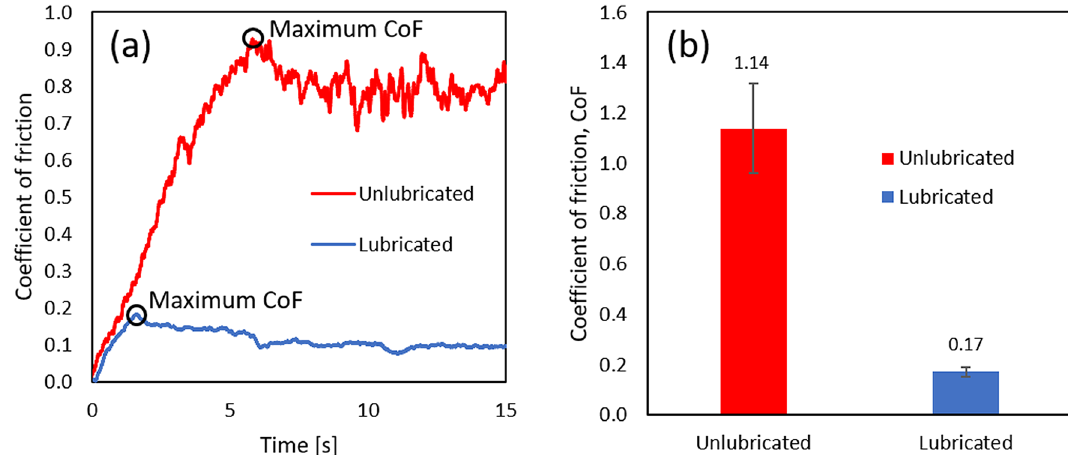
Figure 2. ( a ) Typical friction curves obtained from an individual in-vivo sliding test and ( b ) the average maximum static CoF experienced by the entire cohort and its standard deviation.